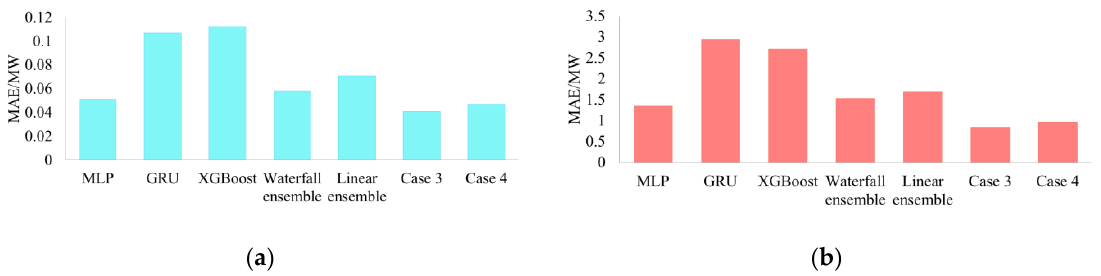
Figure 9. Statistical results of each method: ( a ) average MAE of each method and ( b ) maximum MAE of each method.